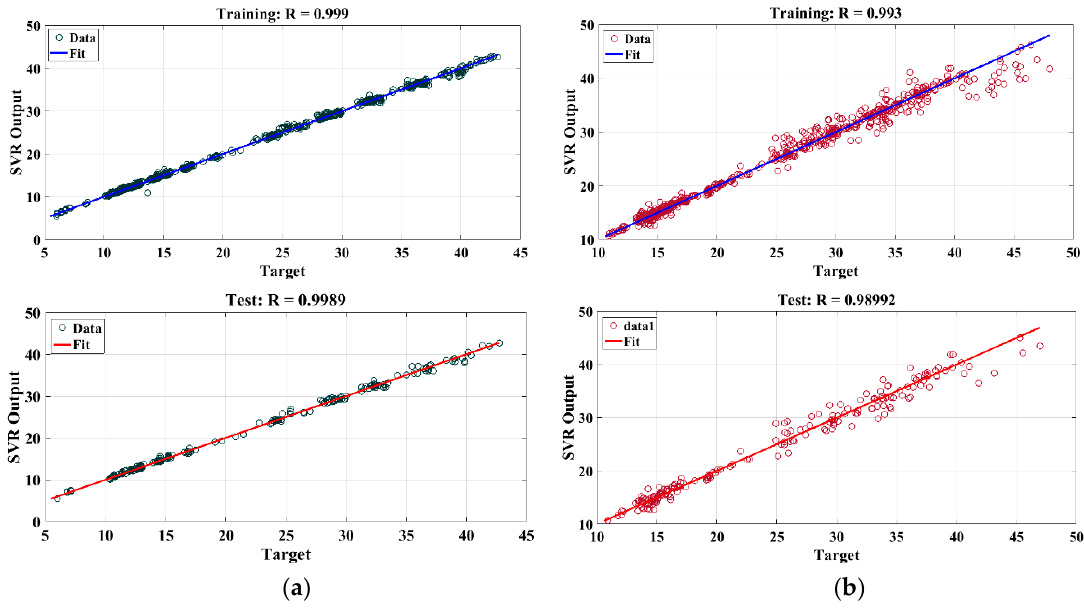
Figure 4. Correlation coefficient between the real value and the output of the SVR; ( a ) heating load; ( b ) cooling load.